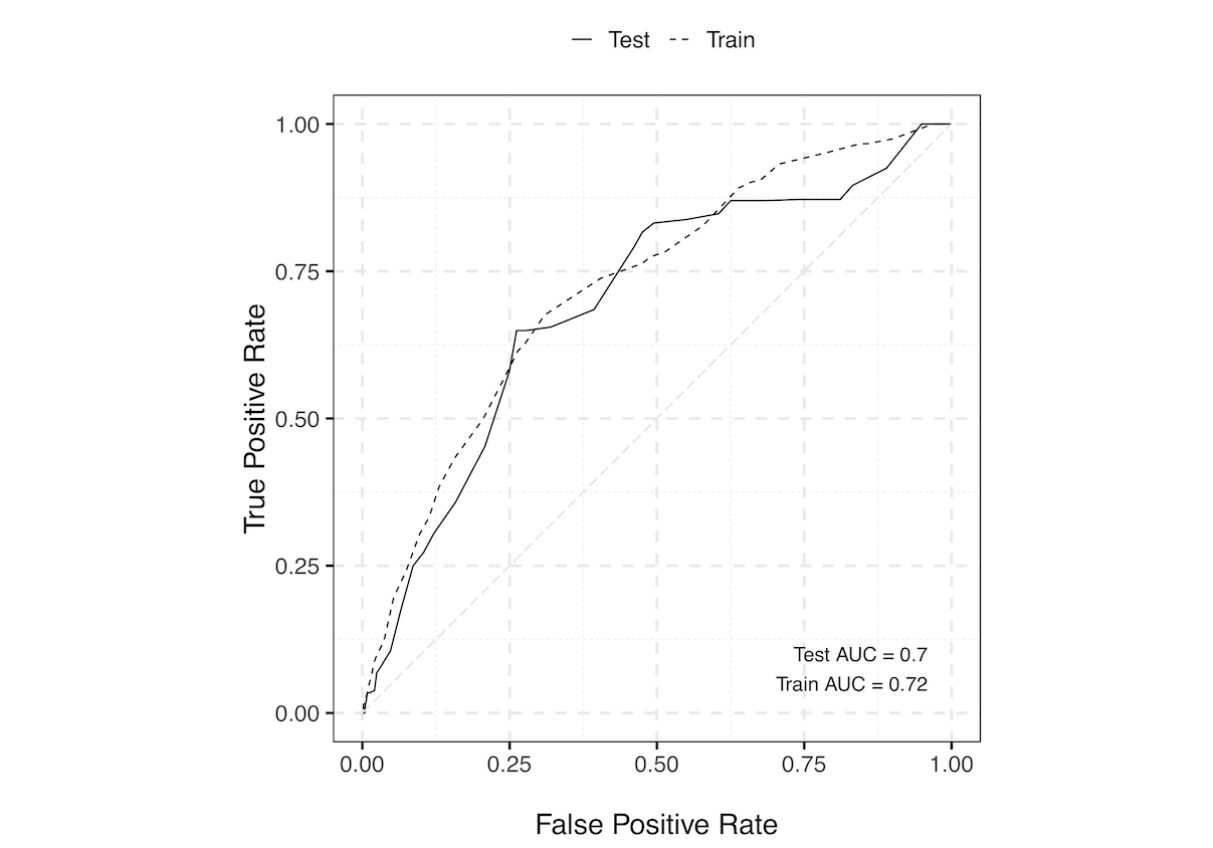
Figure 2. Weighted receiver-operating characteristic (ROC) of the point-based scoring system for predicting dry eye disease. ROCs for train and test sets were compared. AUC: area under the